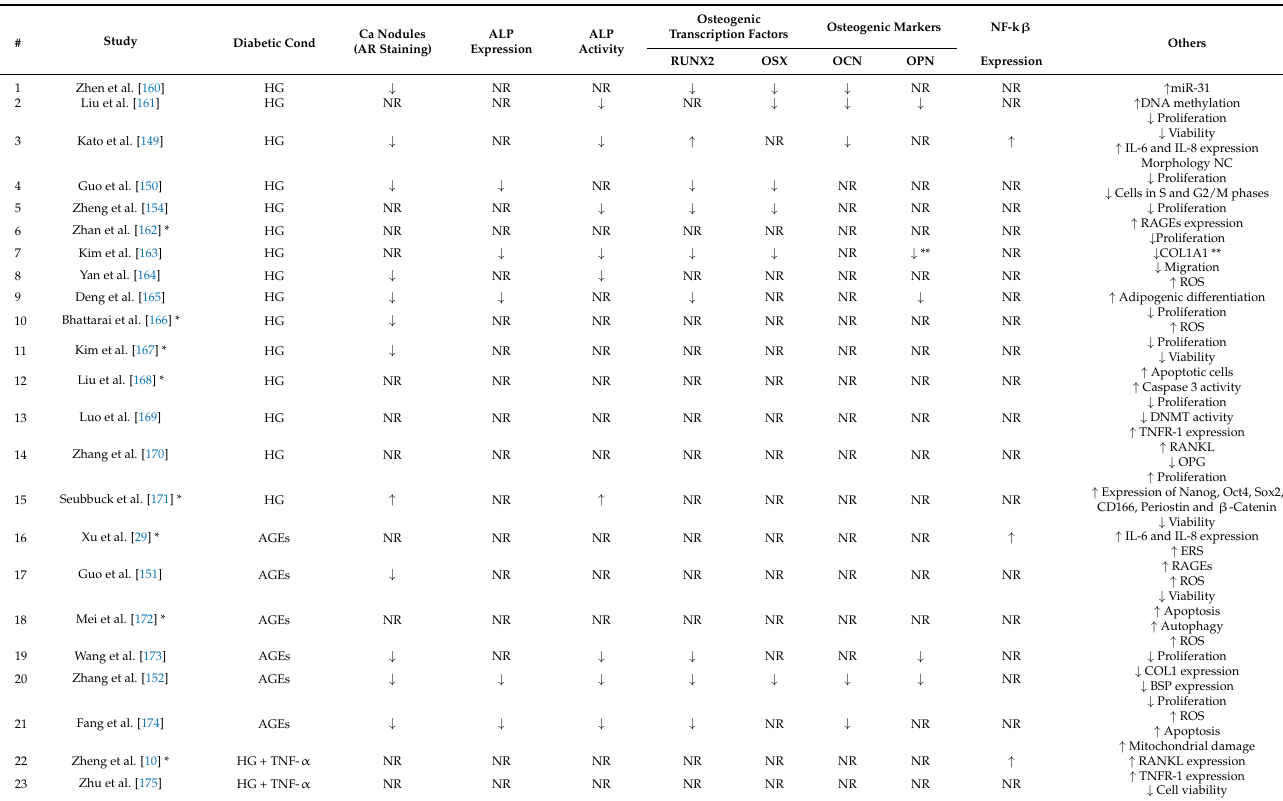
Table 1. Effect of diabetic culture conditions on human PDL-MSCs.